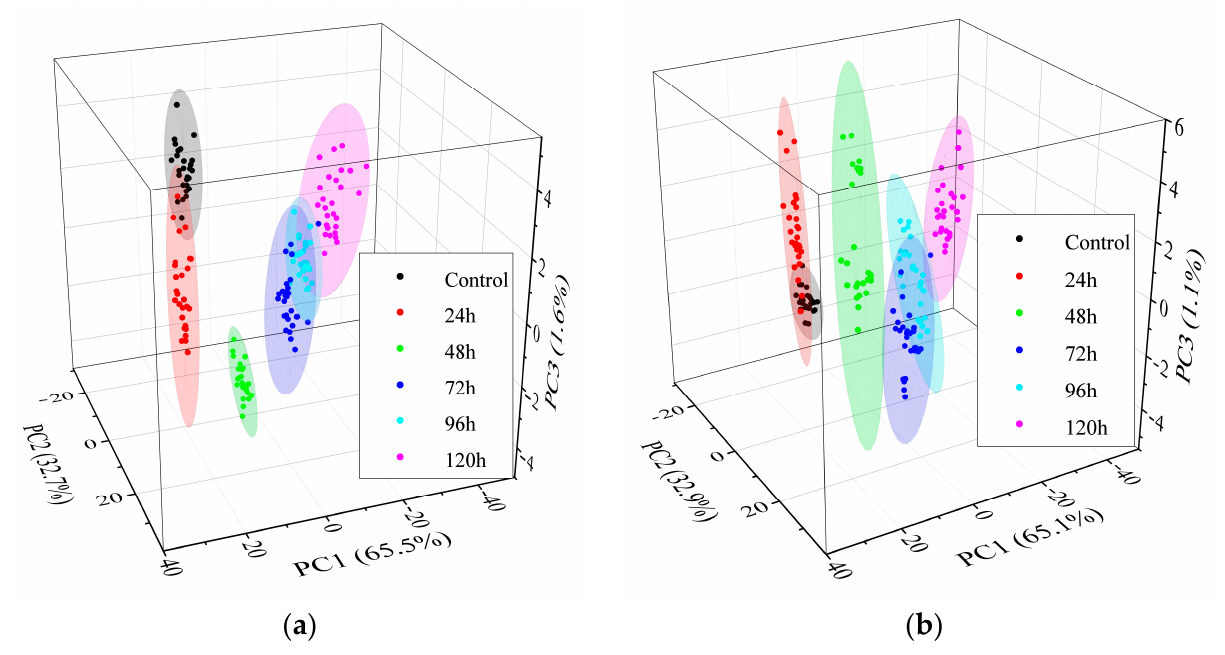
Figure 4. Scores of the first three PCs. MAM inoculated ( a ) NRRL 3357 with concentration of 10 2 spores mL − 1 ; ( b ) NRRL 3357 with concentration of 10 4 spores mL − 1 . The dynamic growth of A. flavus in the MAM caused the curve of spectrum